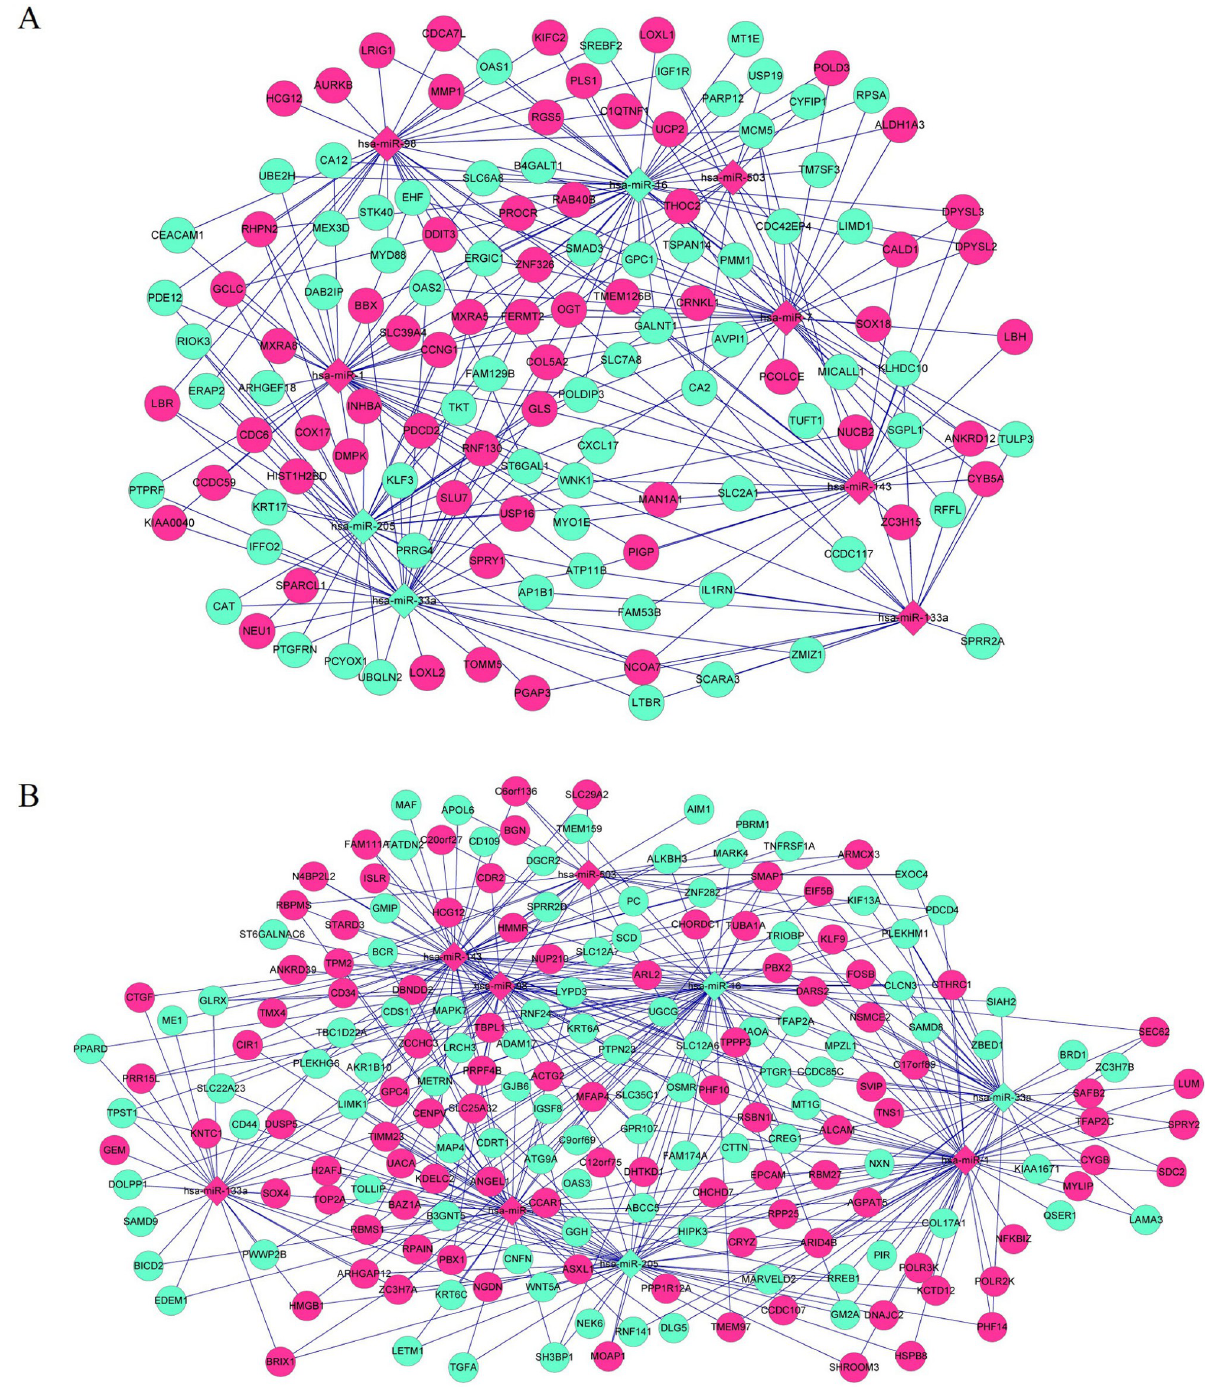
Fig 6. DEM–DEG regulatory network in alcohol-related EC progression. The 12 DEMs in DEL–DEM regulatory network were uploaded to miRTarBase database to predict their targeted genes, and the miRNA-target gene interactions involving DEGs in blue (A) and turquoise (B) modules were screened to construct miRNA-target gene networks, respectively. Diamond and round nodes represent miRNAs and target genes, respectively. Red and green colors represent upregulation and downregulation, respectively. DEM, differentially expressed miRNAs; DEG, differentially expressed